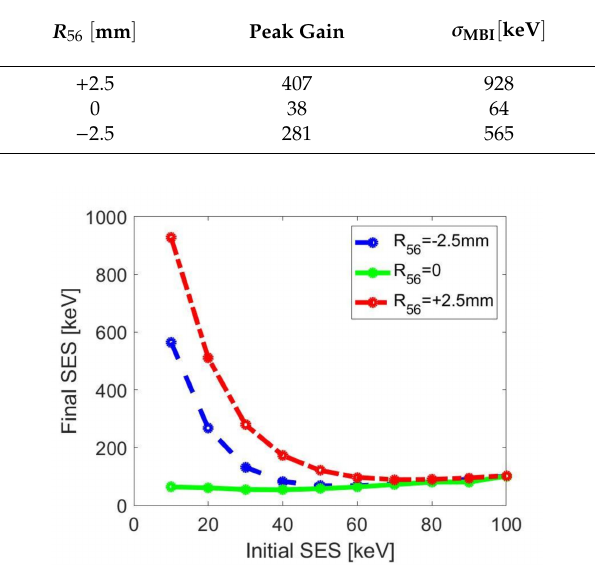
Figure 2. The calculated final slice energy spread (SES, also σ MBI in the text) vs. initial slice energy spread for three switchyard optics (also see Table